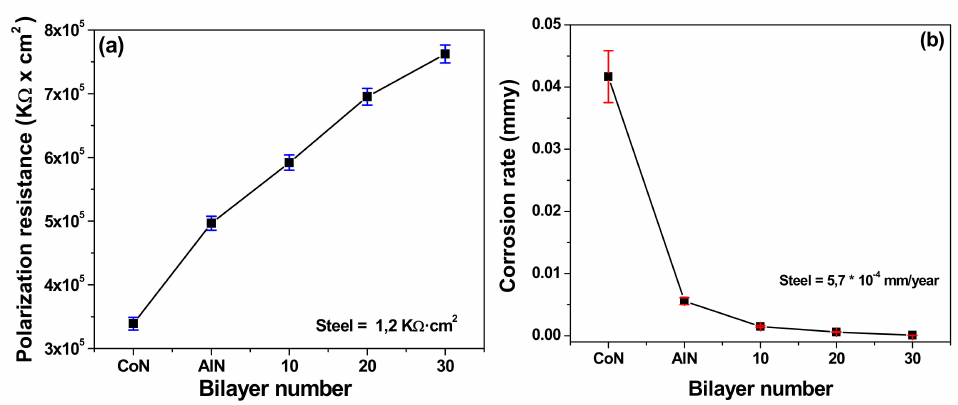
Figure 13. Bilayers number effect on the [AlN/CoN]n multilayers system: ( a ) polarization resistance and ( b ) corrosion